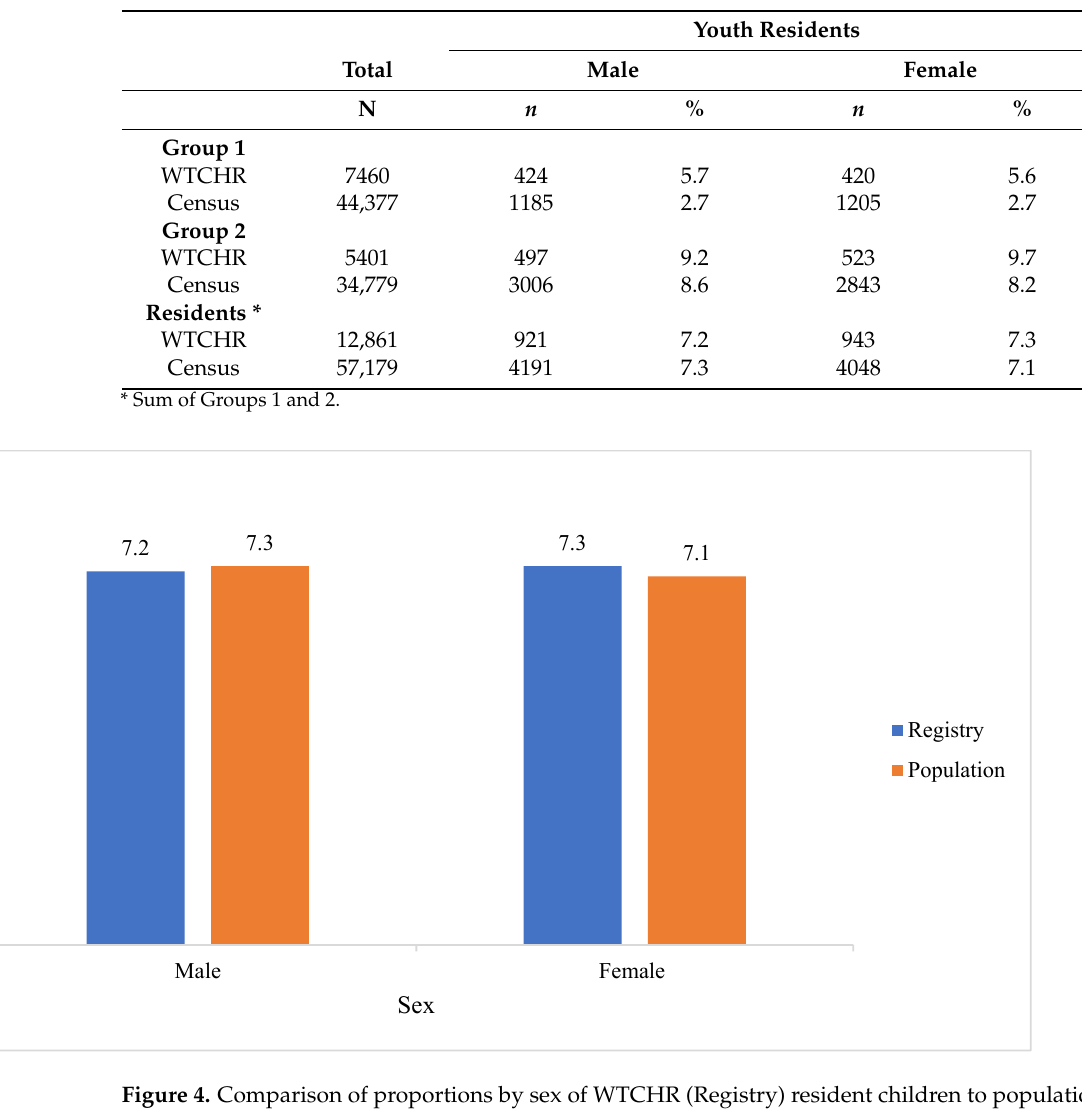
Table 4. Comparison of proportions by sex of WTCHR resident children < 18 years on 11 September 2001 with 2000 census for south of Canal Street in Lower Manhattan. Denominator of proportions is Total for all residents.